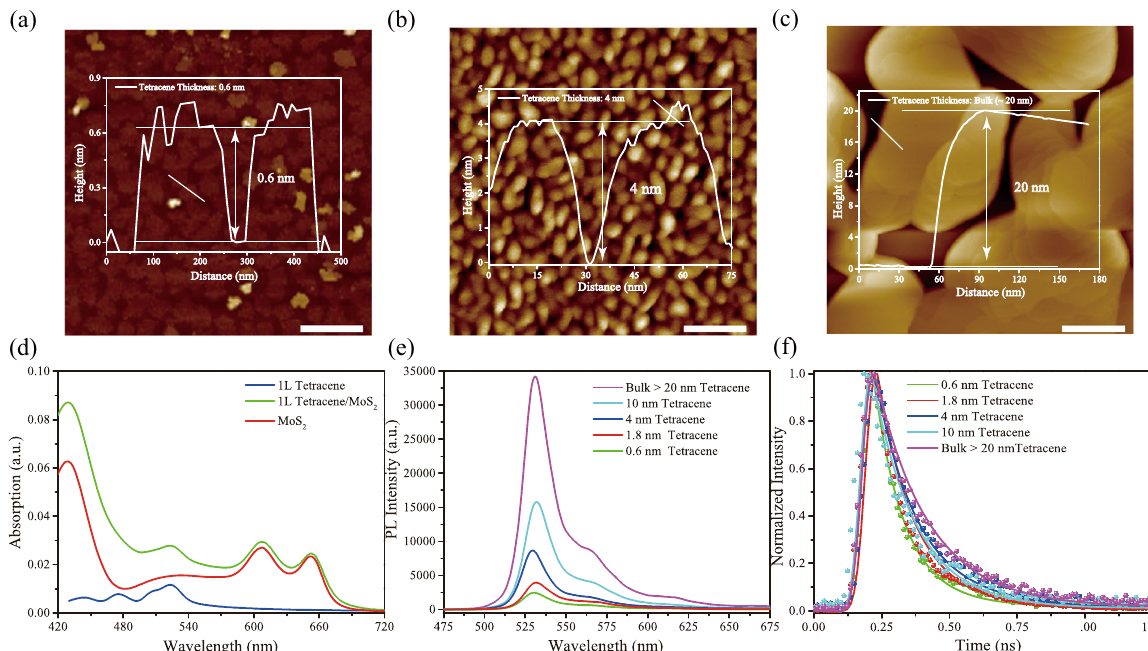
Fig. 2 Thicknesses and exciton dynamics characterizations of O-I heterojunction. a AFM image of 2D (0.6 nm) organic tetracene layer. The test area was indicated with the white line (scale bar: 500 nm). b AFM image of 4 nm organic tetracene layer. The test area was indicated with the white line (scale bar: 100 nm). c AFM image of bulk (>20 nm) organic tetracene layer. The test area was indicated with the white line (scale bar: 200 nm). d Steady-state absorption spectra of monolayer MoS 2 , tetracene and tetracene/MoS 2 organic-inorganic heterostructure, respectively. e Steady-state PL spectra of tetracene layer with different thicknesses. f Normalized time-resolved PL decay pro fi les of tetracene layer with different